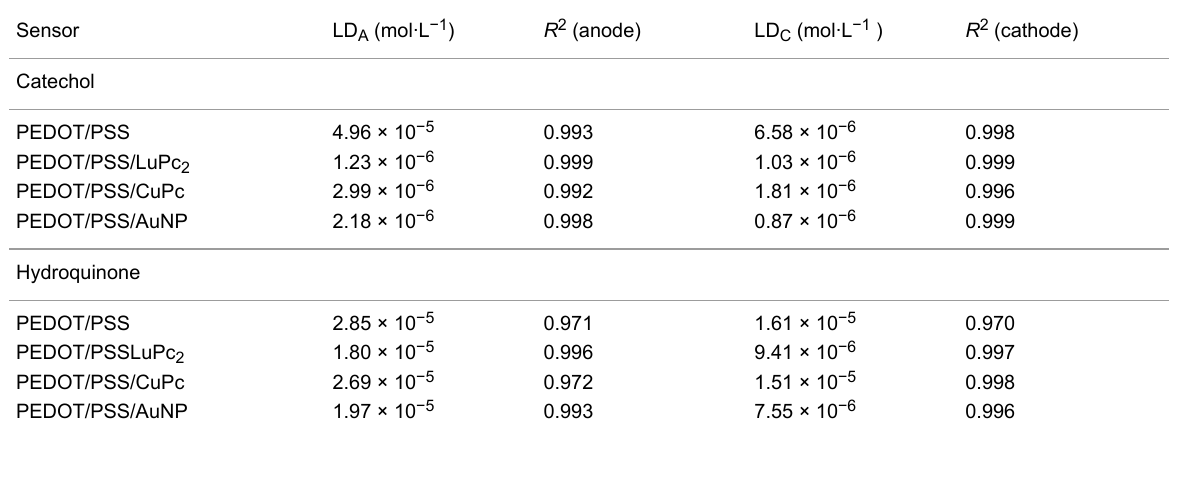
Table 5: Limit of detection and regression coefficients obtained for catechol and hydroquinone using the anodic (LD A ) and the cathodic (LD C ) peaks.